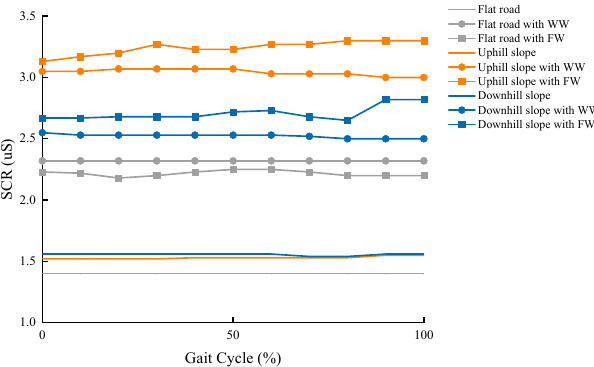
Figure 7. Comparison of the SCR observed during different